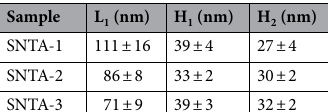
Table 1. The observed morphology parameters of SNTA-1, SNTA-2, and SNTA-3 from SEM images.